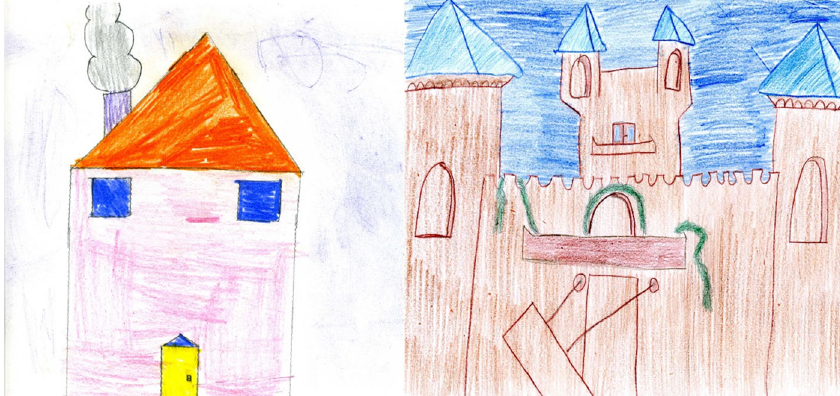
Fig. 2 Drawing of the real house vs. the desired house. F., 10 years old. Example of the use of Strategies 1, 2, 3, and 4, and increases in architectural details, dimensions; change of type of building.